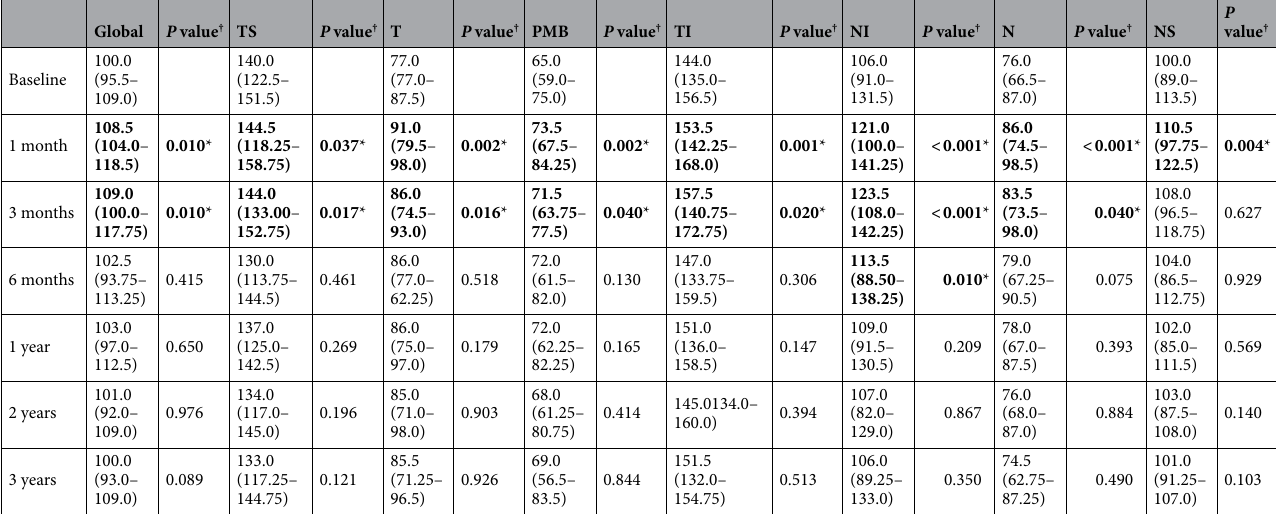
Table 3. Circumpapillary retinal nerve fiber layer thickness changes after surgery. Significant values are in bold. Data are presented as median (interquartile range). G Global area, TS Temporal superior, TI Temporal inferior, NS Nasal superior, NI Nasal inferior, T Temporal, N Nasal, PMB Papillomacular bundle. *Denotes a significant difference ( P < 0.05). † Wilcoxon signed-rank test (compared with baseline